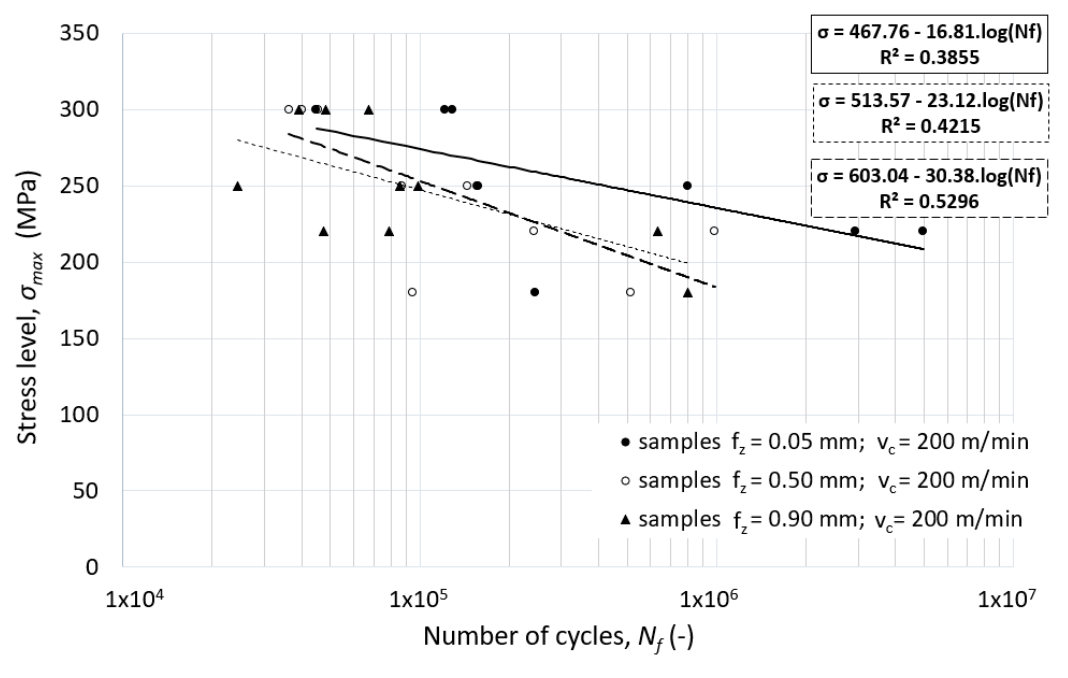
Figure 18. The effect of the cutting speed combined low feed cutting on the fatigue life of alloy 7475- T7351—flat un-notched specimen.